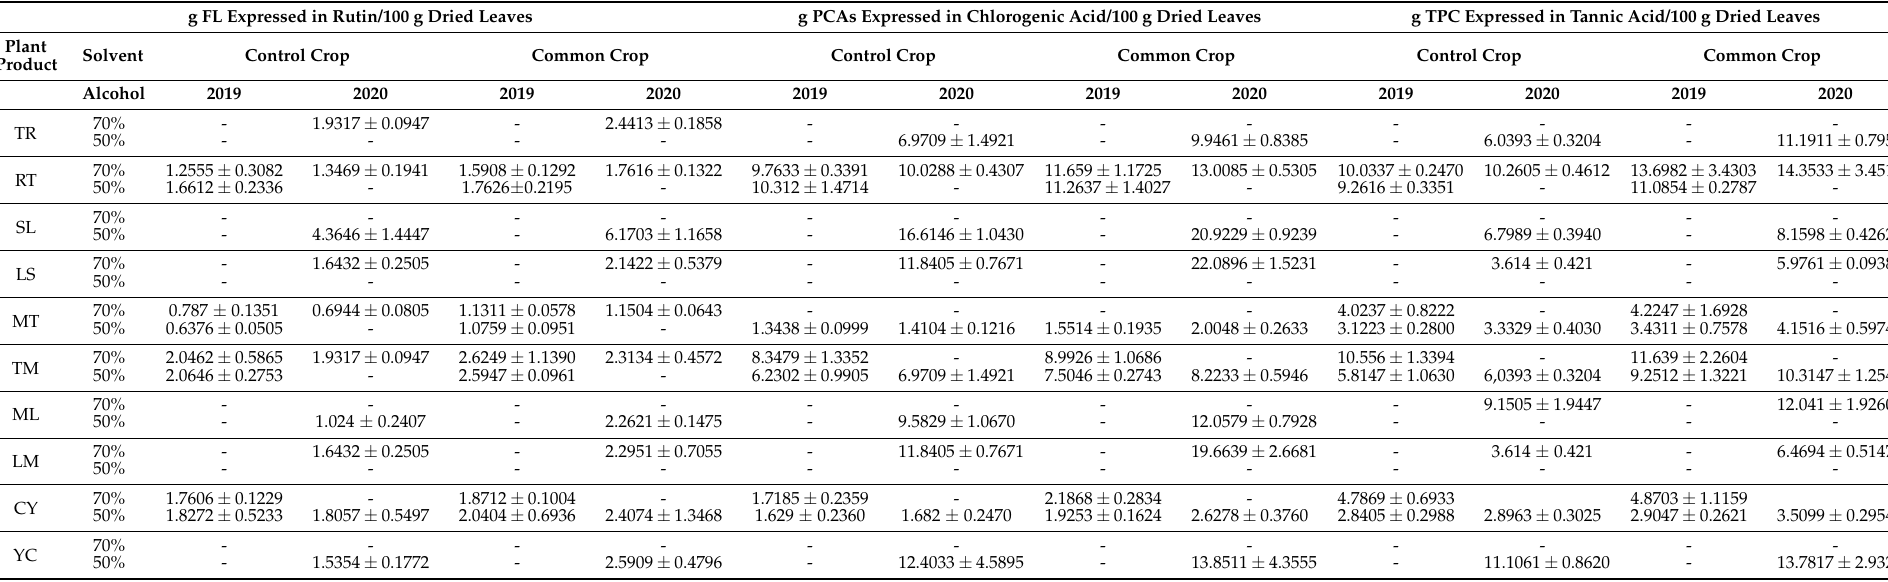
Table 6. Results for spectrophotometric and volumetric assay for every medicinal plant in the culture. g FL Expressed in Rutin/100 g Dried